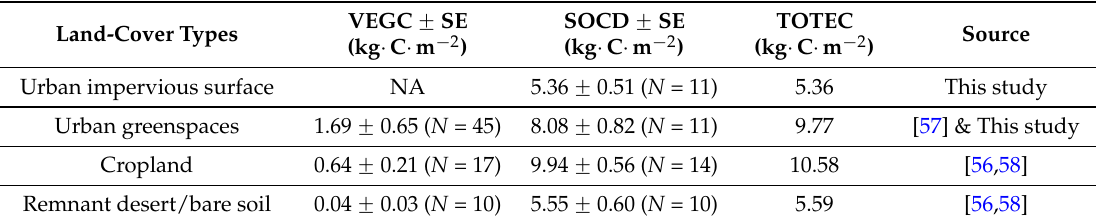
Table 5. Vegetation C (VEGC), soil organic C (SOC), and total ecosystem C (TOTEC) of different land-cover types in the study region.